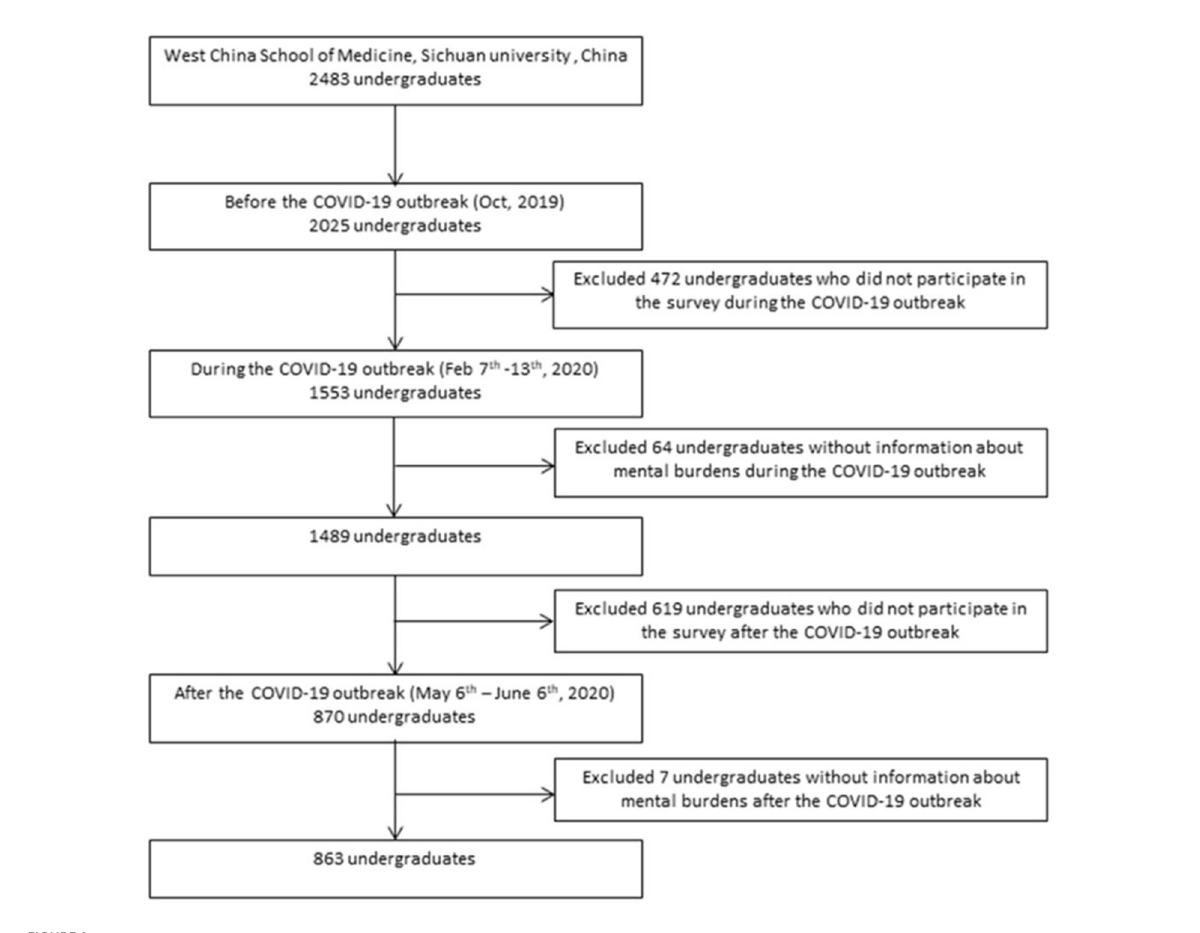
FIGURE1 The study flow